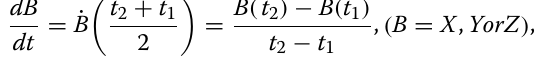
Fig. 3 The Z (first row) and F (second row) maps showing SACFM-3 (first column) and CHAOS-6- column) at 2019.0 epoch and 0 km